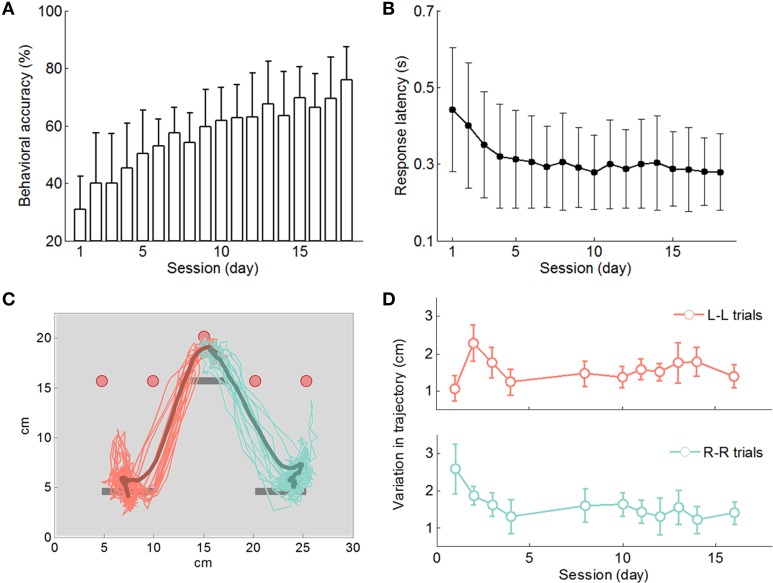
Behavioral results. (A) Rats (n = 9) improved behavioral accuracy to a level above 70% in 18 days on average. (B) The response latency decreased mainly during the initial days and stayed relatively stable afterwards. (C) Movement trajectory (head position) during the cue onset period projected onto the front view of the interface panel. Thin traces: trajectory records from single trials. Bold curves: mean trajectory traces of left side and right side movements. (D) Variation in movement trajectory (distance between the trajectory trace of a single trial and the mean trajectory) decreased during initial learning sessions.